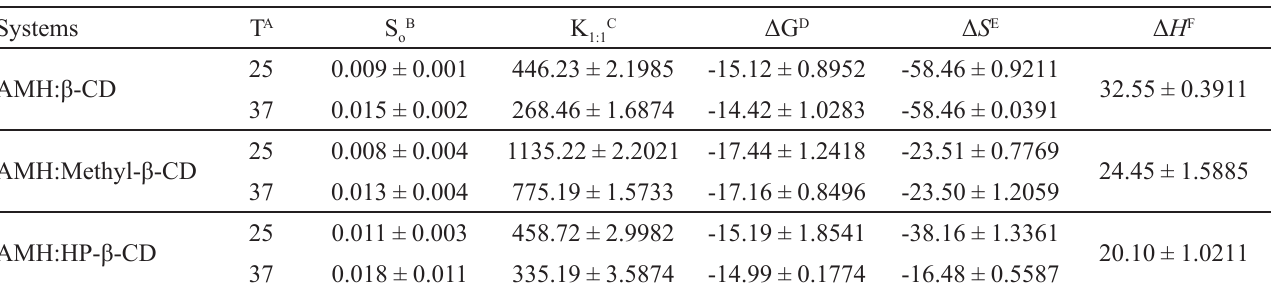
A Temperatures evaluated in (ºC); B Solubility of AMH in the absence of cyclodextrins (mM); C Apparent complexation constant (M -1 ); D Change in Gibbs-free energy (KJ mol -1 ); E Change in entropy (J mol -1 K -1 ); F Change in enthalpy (KJ mol -1